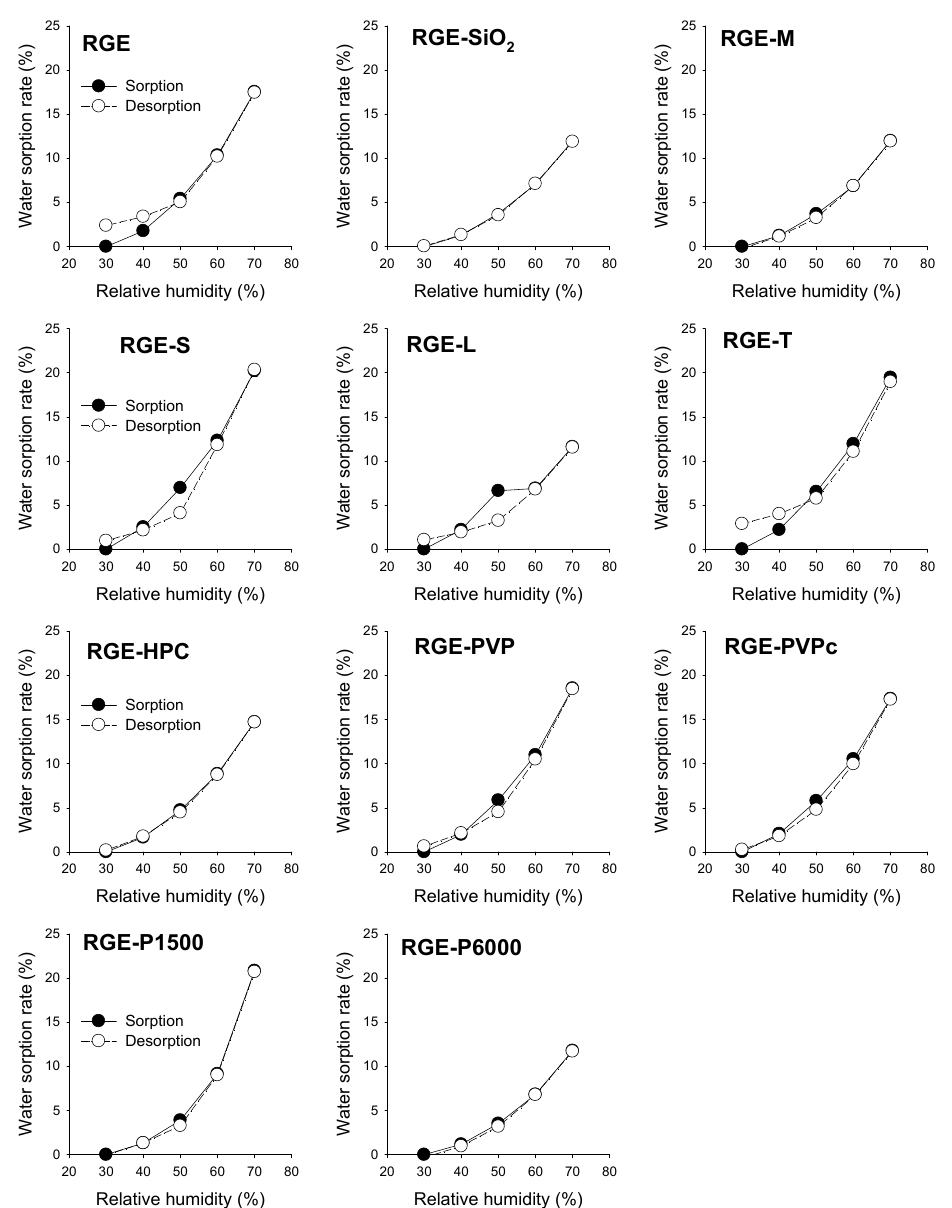
Figure 4. Water sorption–desorption rate curves of solid dispersion formulations of red ginseng extract (RGE) stored in a thermo-hygrostat with increasing relative humidity (from 30% RH to 70% RH; ● ) and decreasing relative humidity (from 70% RH to 30% RH; ○ ) at 30 °C. Data represent the mean ± standard deviation ( n = 3). RGE: solid dispersion of red ginseng extract; RGE-SiO 2 : solid dispersion of RGE with silicon dioxide; RGE-M: solid dispersion of RGE with mannitol; RGE-S: solid dispersion of RGE with sucrose; RGE-L: solid dispersion of RGE with lactose; RGE-T: solid dispersion of RGE with trehalose; RGE-HPC: solid dispersion of RGE with hydroxypropyl cellulose; RGE-PVP: solid dispersion of RGE with polyvinyl pyrrolidone; RGE-PVPc: solid dispersion of RGE with cross-linked polyvinyl pyrrolidone; RGE-P1500: solid dispersion of RGE with PEG1500; RGE-P6000: solid dispersion of RGE with PEG6000.